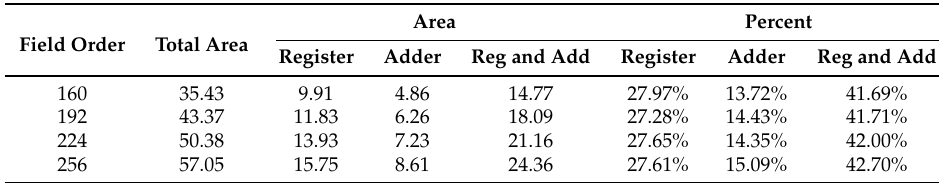
Table 3. Hardware consumption of register and adder on ASIC.